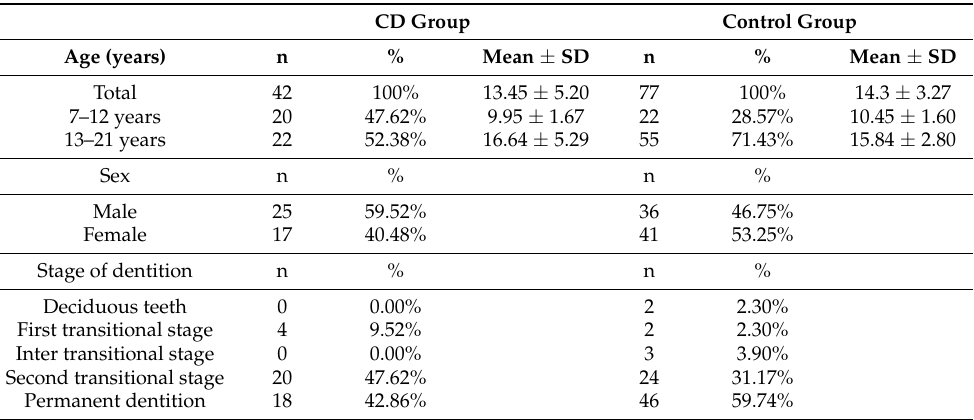
Table 1. Descriptive evaluation of study participants (n = 119) divided in craniofacial disorder (CD) and control group with respect to age, age groups, sex and stage of dentition. A count of patients and the respective percentage of the population is given for all values, whereas mean and standard deviation (SD) is shown for age